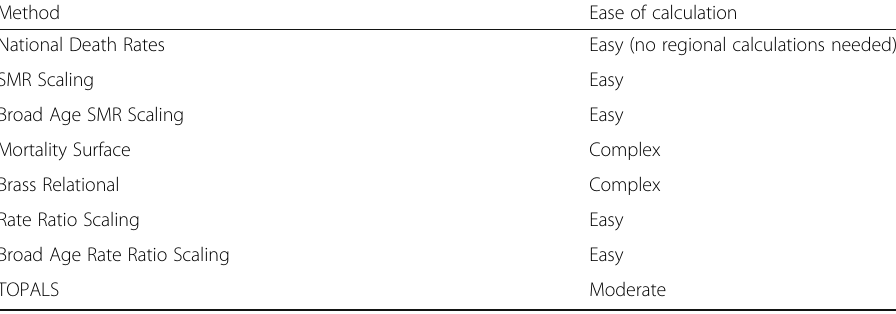
Table 3 Relative ease of calculation of the eight regional mortality forecast